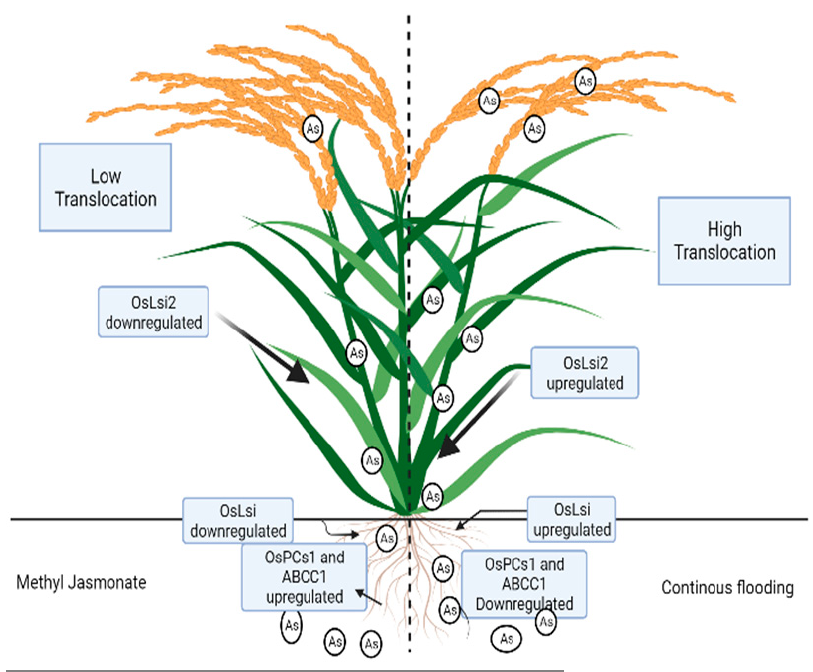
Figure 4. Continuous flooding increases arsenic (As) uptake by rice through the downregulation of phytochelatin encoding gene OsPCS1 and ABCC ‐ type transporter gene OsABCC1 and upregulat ‐ ing low silicon rice genes Lsi1 and Lsi2 . Methyl jasmonate (MJ) decreases translocation by down